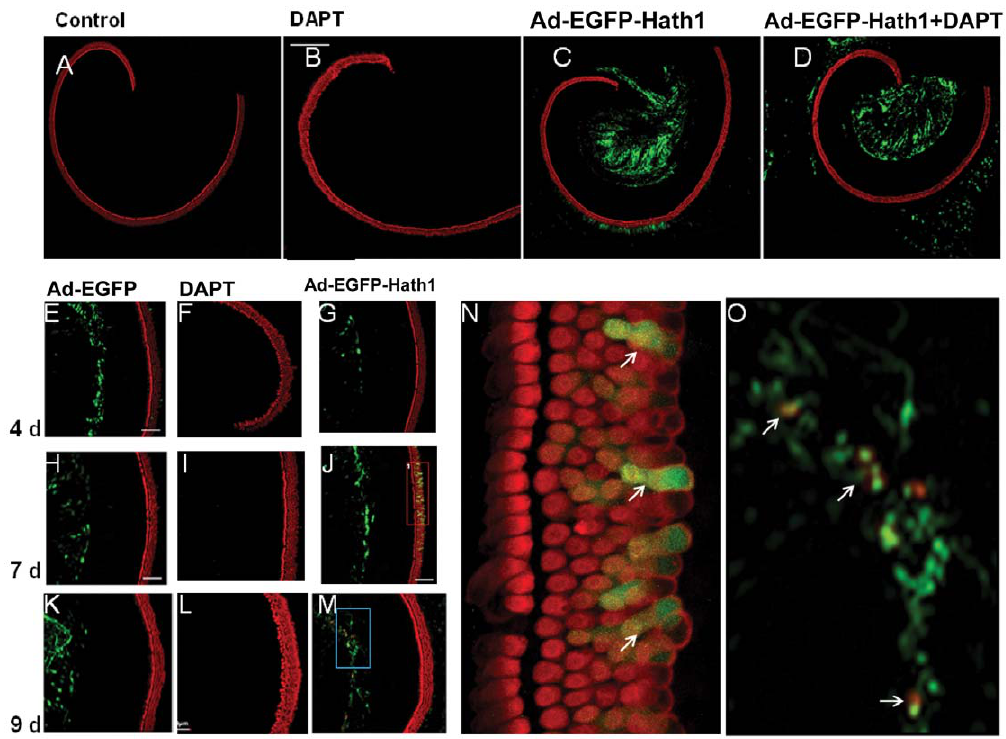
Figure 1. The overexpression of EGFP and Atoh1 in the Organ of Corti. A–D: Cultured Organ of Corti whole mounted on the bottom of the Petri dish in vitro. A: Control sample without treatment. B: With DAPT treatment. C: With ad-EGFP-Atoh1 overexpression. D: With ad-EGFP-Atoh1 overexpression and DAPT treatment. E–M: parts of the cultured basilar membrane for 4–9 days. E, H, K: Cultured basilar membranes transfected with adenovirus that carrying EGFP gene for 4, 7, and 9 days, indicating the expression of EGFP in the region of great epithelia ridge (GER). F, I, L: Cultured basilar membranes treated with DAPT for 4, 7, and 9 days. G, J, N: Cultured basilar membranes transfected with adenovirus that carrying EGFP and Atoh1 gene for 4, 7, and 9 days. N, Enlarged picture in the red Frame in panel J. white arrows indicating the extra hair cells express Myosin VIIa and EGFP in the Organ of Corti. O: Enlarged picture in the blue Frame in panel M (indicating the cells express Myosin VIIa and EGFP in GER region (white arrows). Green channel: EGFP expression. Red channel: Myosin VIIa expression.